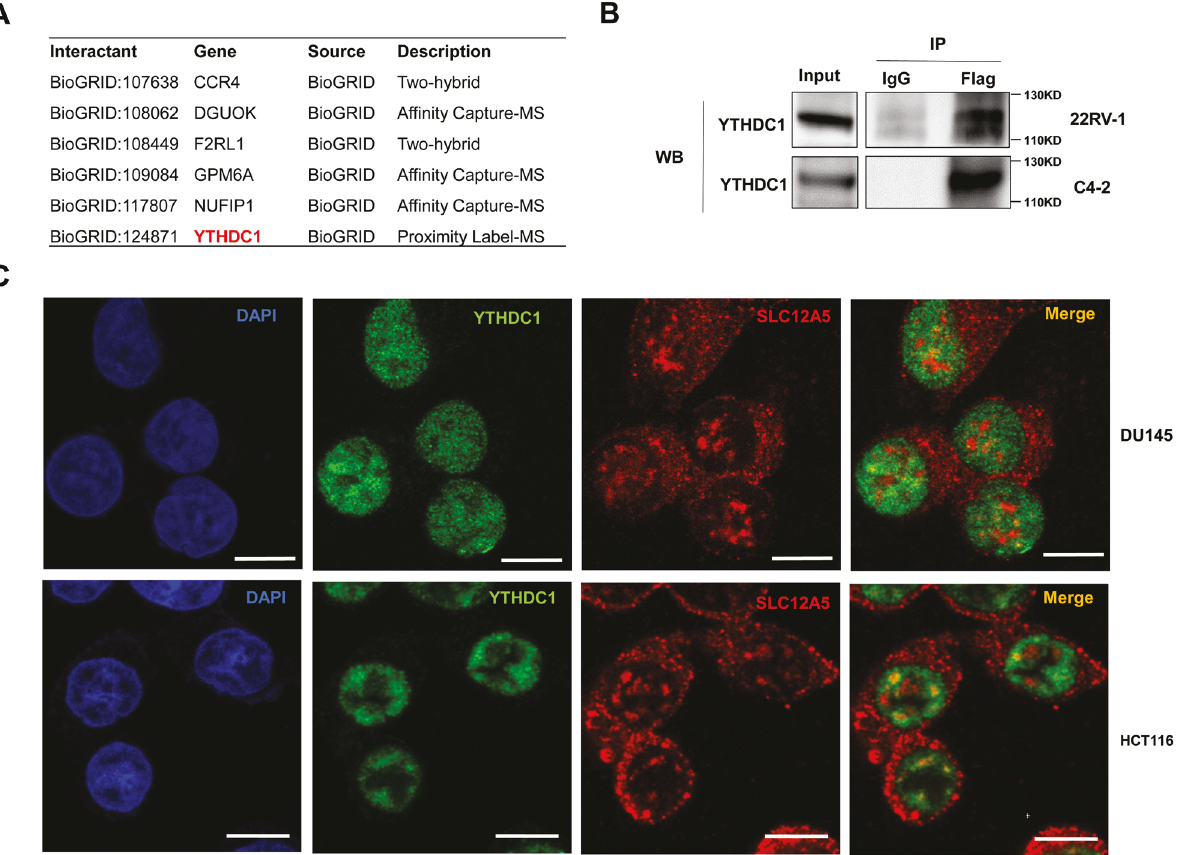
Fig. 5 SLC12A5 protein binds to YTHDC1 in the nucleus. A The protein interactions of SLC12A5 were predicted using BioGRID. B The binding effects of SLC12A5 and YTHDC1 were detected by Co-IP assay in 22RV-1 and C4-2 cells transfected with Flag-tagged SLC12A5 fusion vector. C Immuno fl uorescence staining was performed to clarify the binding effects and co-localization of endogenous SLC12A5 and YTHDC1 in SLC12A5 high-expressing prostate and colorectal cancer cells. Scale bars represent 10 μ